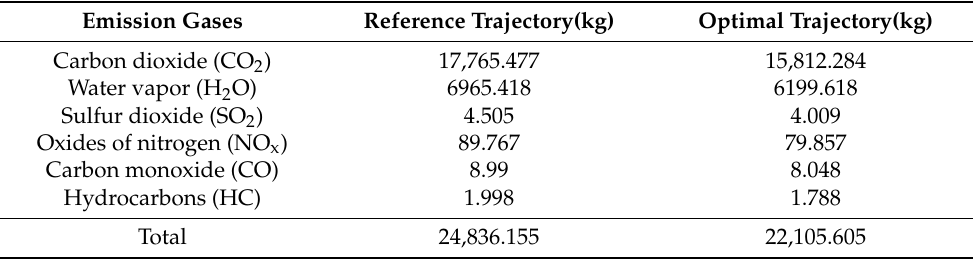
Table 6. Aircraft emissions of reference and emissions-optimal global